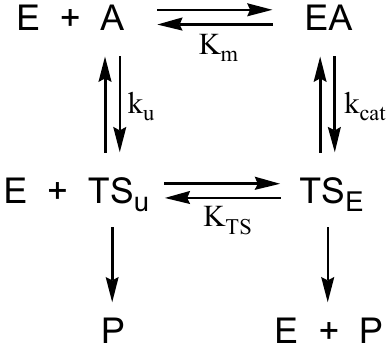
Figure 2. Thermodynamic cycle for estimation of transition state stabilization in AChE catalysis. E, EA, A, P, TS u , and TS E are respectively free enzyme, Michaelis complex, substrate, product, transition state of the spontaneous hydrolysis reaction, and transition state of the AChE-catalyzed reaction. K m and k cat are the respective Michaelis constant and turnover number of the AChE-catalyzed reaction; k u and K TS are respectively the rate constant of the spontaneous hydrolysis reaction and the dissociation constant of the enzymic transition state.